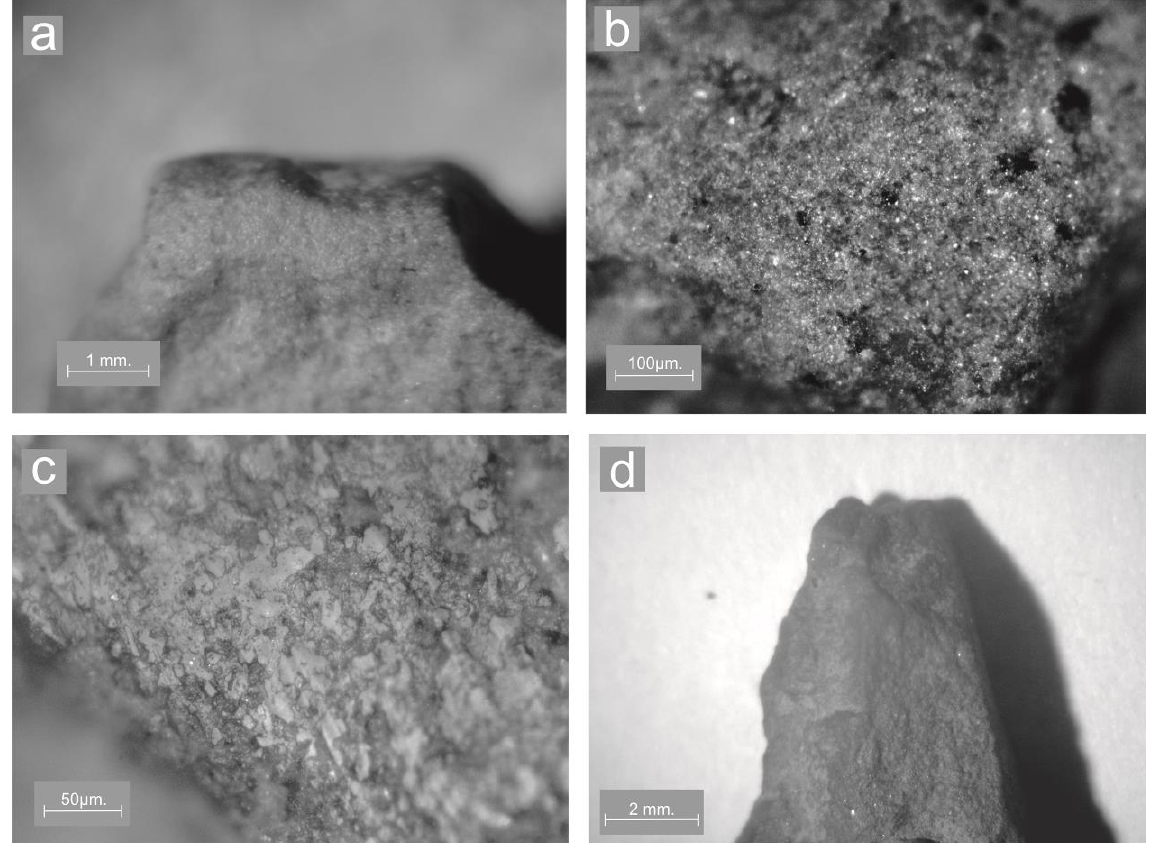
Figure 6. The example of probable use-wear traces observed on stone (non-flint) artefacts from Ludowice 6. The collection from Ludowice contained 99 artefacts of red quartzite